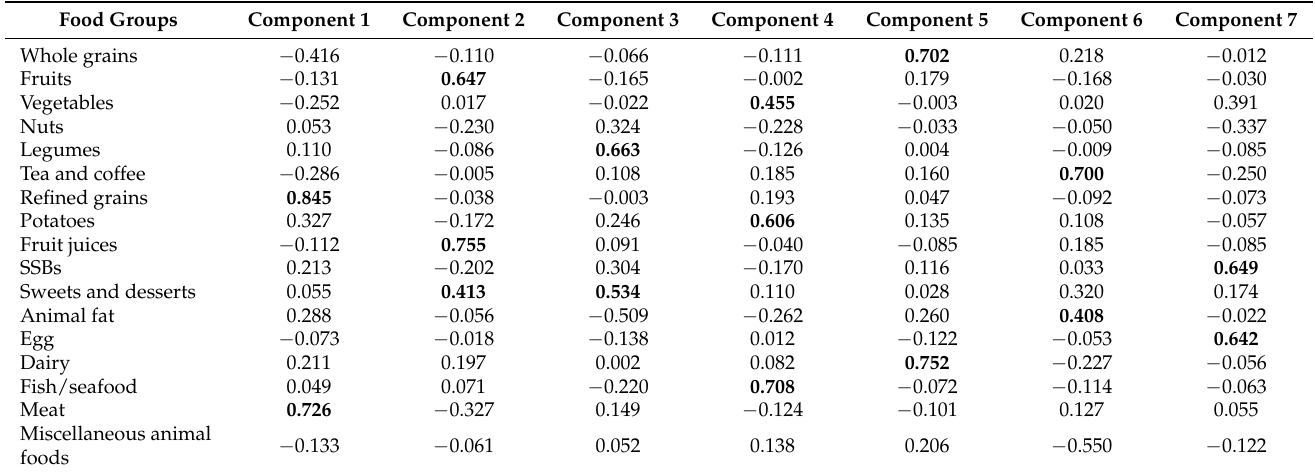
Table 6. Seven components extracted and retained from the PCA.